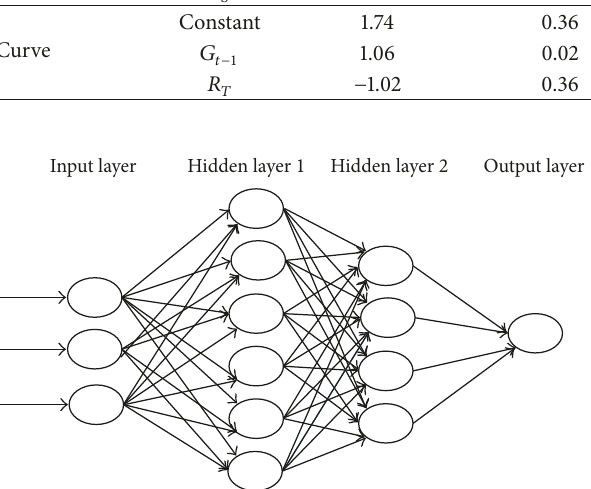
Figure 3: A typical architecture of a four-layered ANN model.